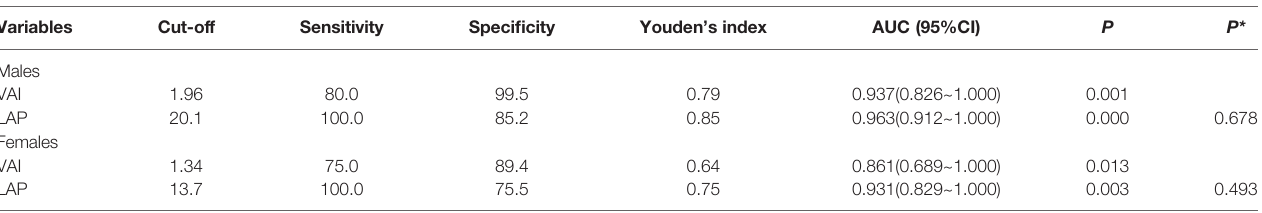
TABLE 3 | The outcomes of AUC between males and females. Variables